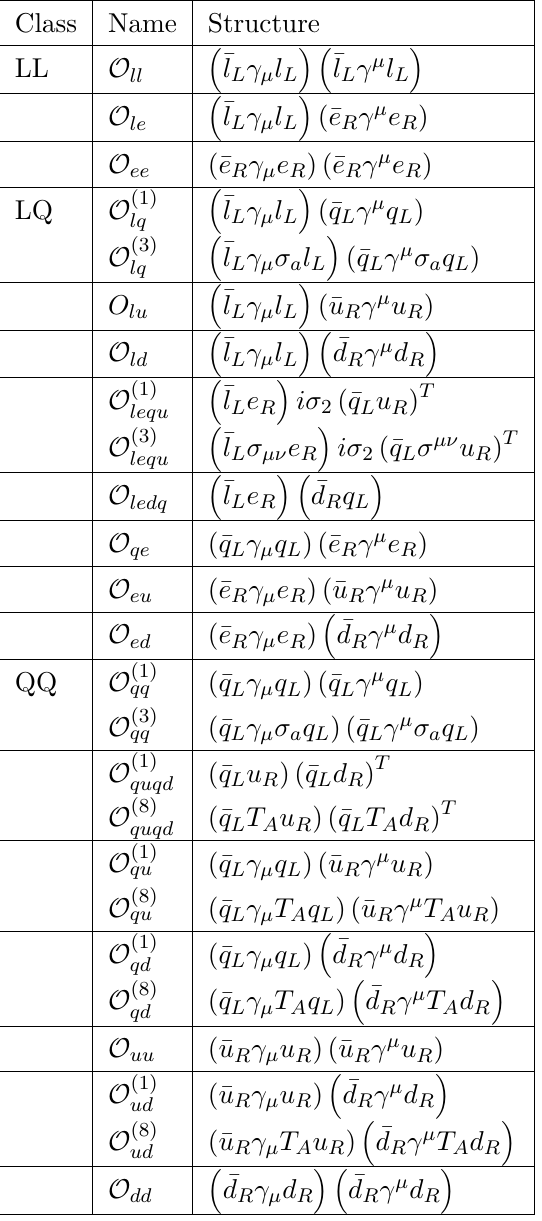
Table 1. List of baryon (and lepton) number conserving 4F operators in the Warsaw basis at d = 6. Note that we have suppressed generation indices